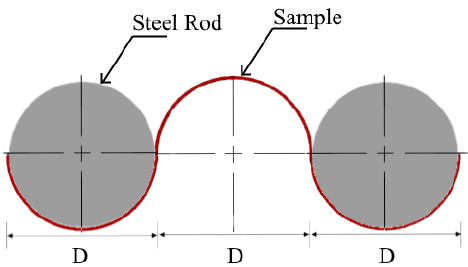
Figure 3. Design of the half-cane configuration to increase membrane stiffness detailing the geometrical details and fixation to steel rods.